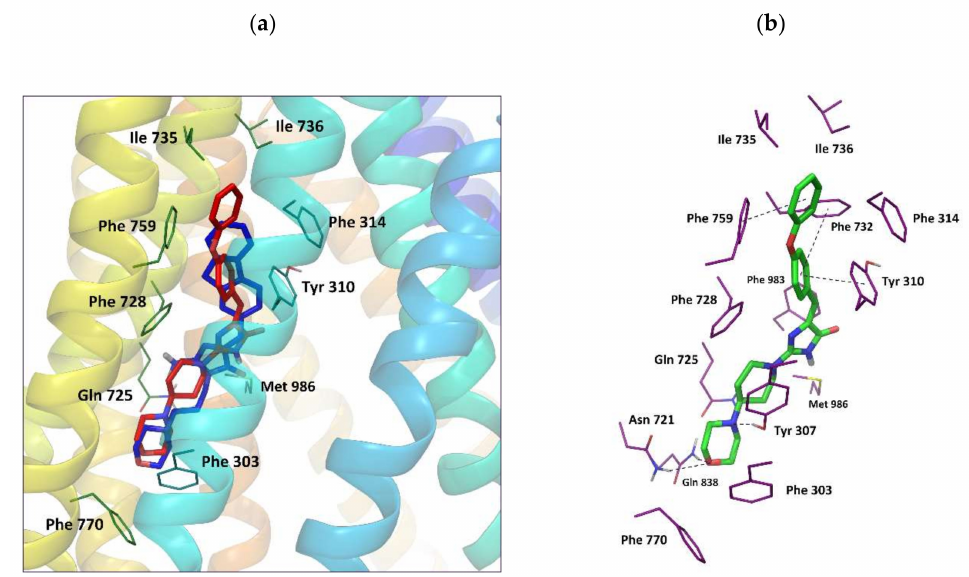
Figure 7. ( a ) Binding mode of compounds 11 and 18 adopting docking pose 3; ( b ) molecular interactions for the best docking pose 3 represented by compound 11